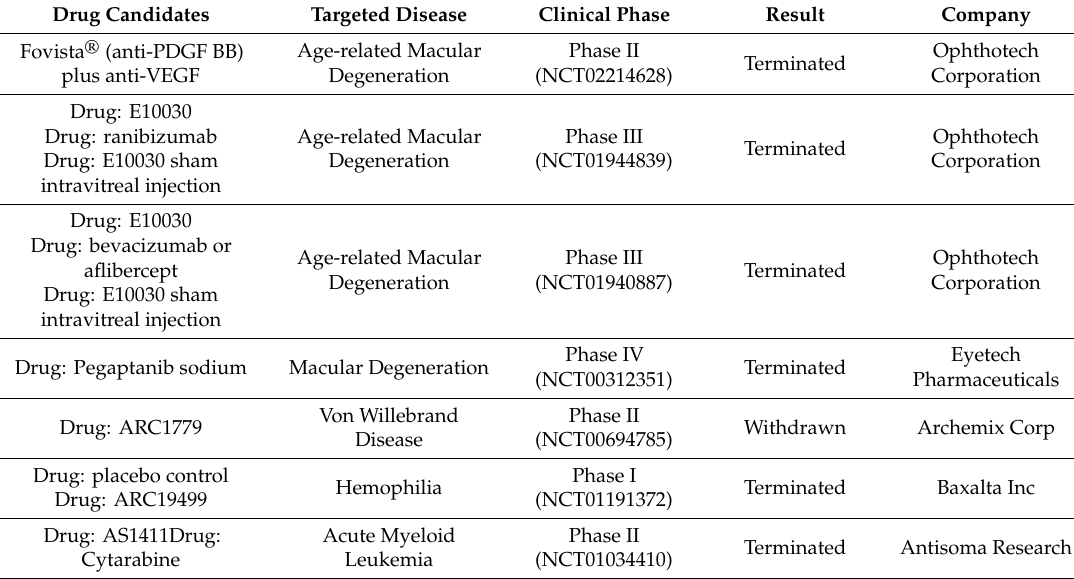
Table 4. Nucleic acid aptamers removed from the clinical